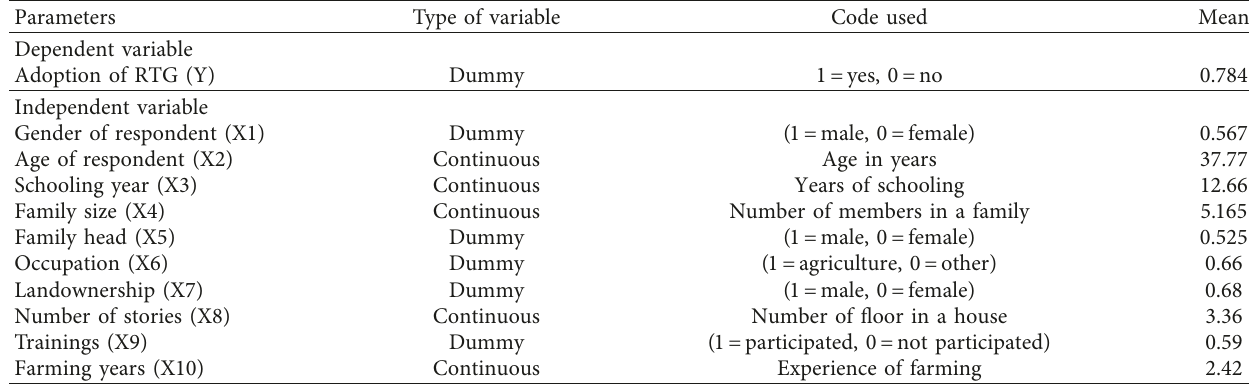
Table 2: Details of the parameters used in binary logit regression